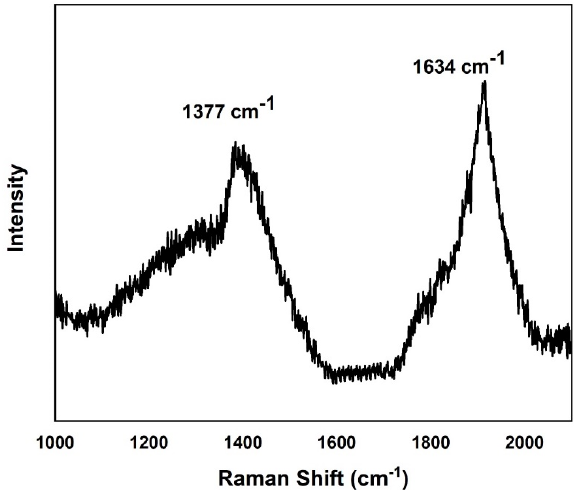
Figure 4. Raman spectrum of CDs.